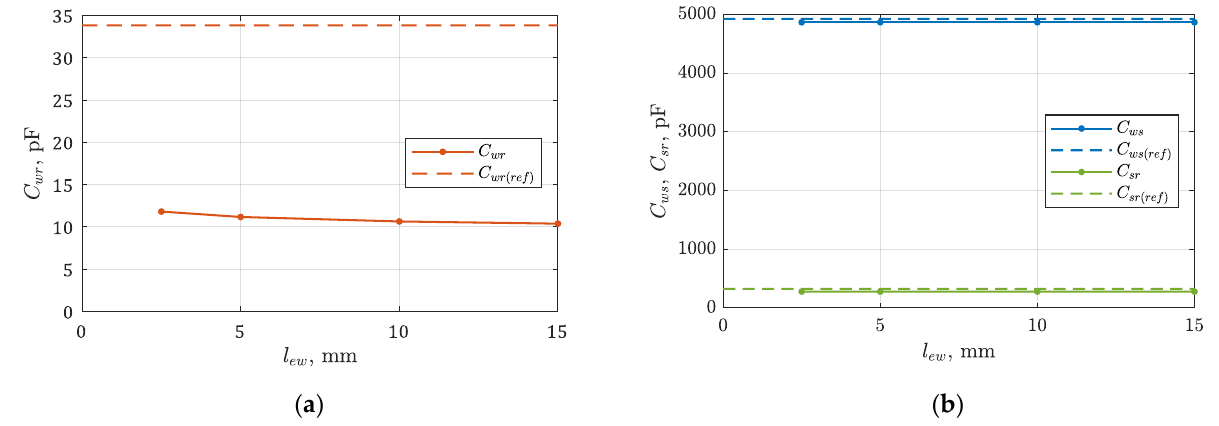
Figure 13. The results of the calculations of parasitic capacitances: C wr ( a ) and C ws , C sr ( b ) for different overhang lengths of the shielding winding and the wire diameter d w = 0.5 mm compared to the capacitance values of the reference model.